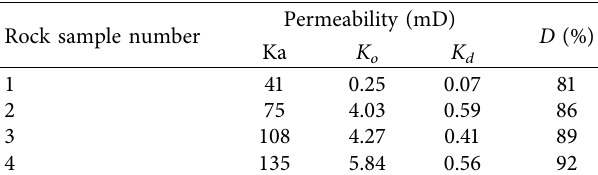
Table 5: Experiment on the efect of cement slurry fltrate on core